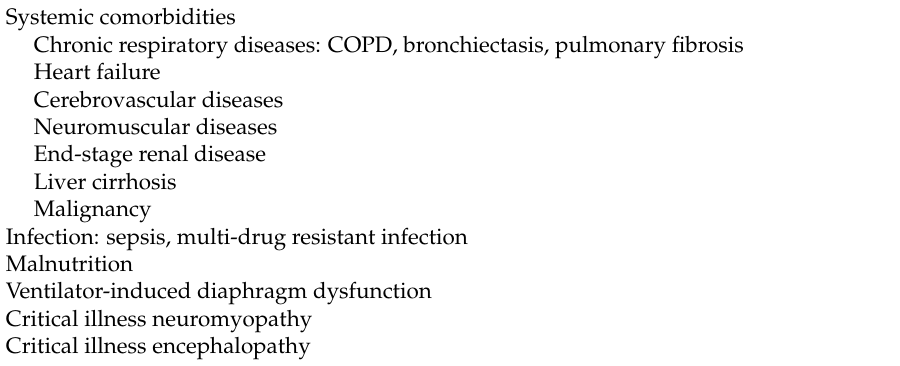
Table 1. Risk factors of prolonged mechanical